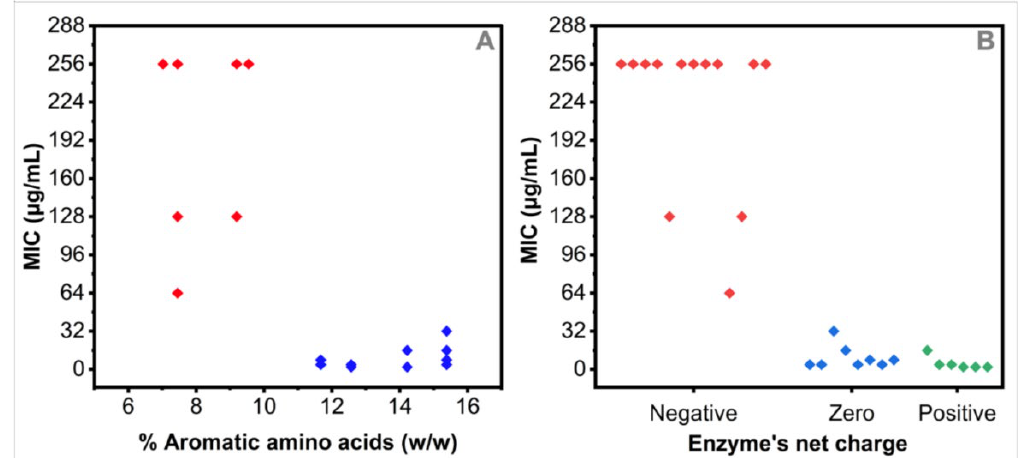
Figure 5. Scatter plots showing the relationships between the observed MIC values and the percentage aromatic amino acid content ( A ), as well as the net charge ( B ) of the resistance enzymes expressed by the studied MDR strains of E. coli and K. pneumoniae .